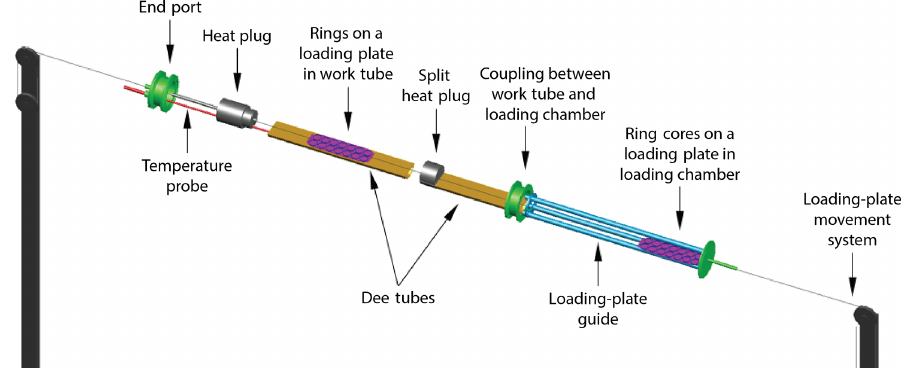
Figure 12. Exploded view of the internal components of the furnace and the loading chamber. Ring cores were staged in the loading chamber for rapid insertion after the furnace reached the nominal dwell temperature.